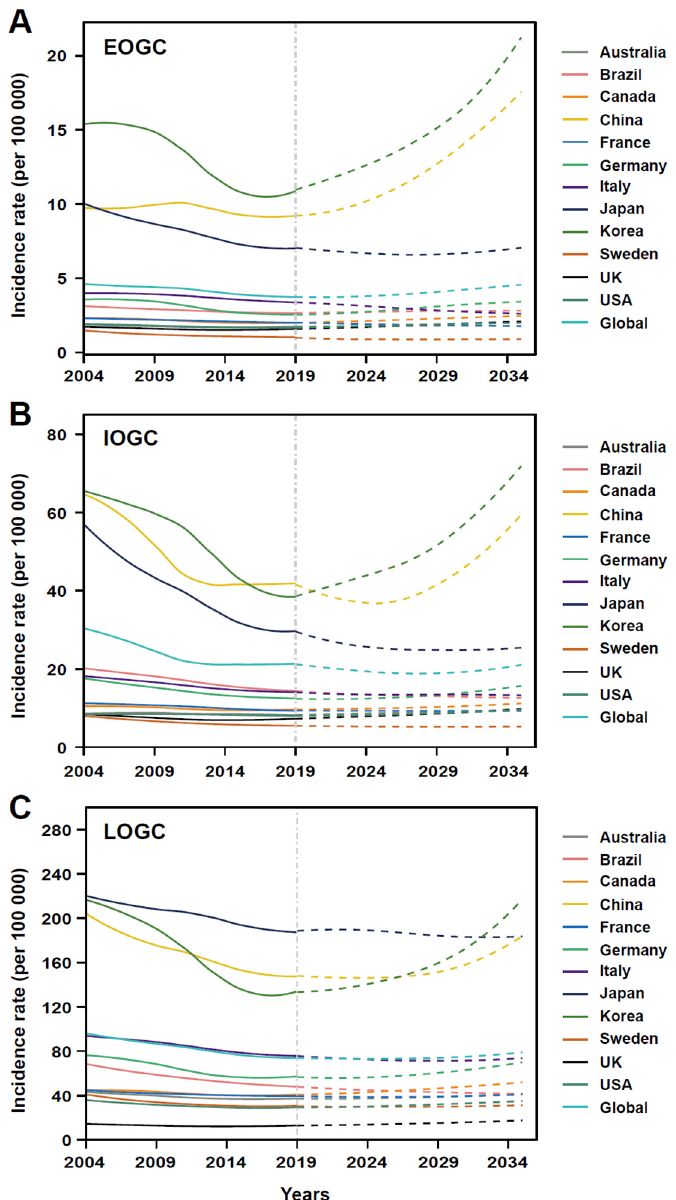
Figure 4. Predictions for gastric cancer from 2020 to 2035 globally and in 12 countries. ( A ) Predictions of incidence rate for early-onset gastric cancer from 2020 to 2035 globally and in 12 countries; ( B ) Predictions of incidence rate for intermediate-onset gastric cancer from 2020 to 2035 globally and in 12 countries; ( C ) Predictions of incidence rate for later-onset gastric cancer from 2020 to 2035 globally and in 12 countries.